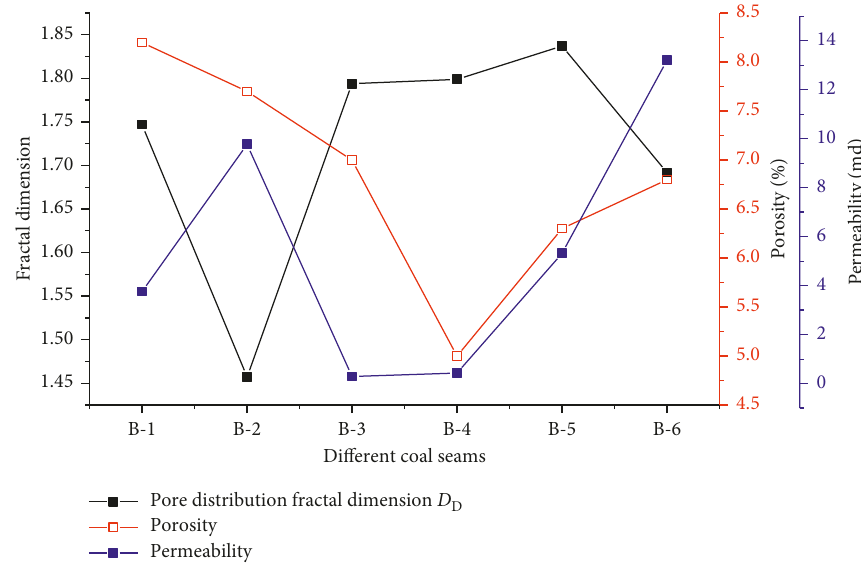
Figure 12: Fractal dimension, porosity, and permeability for the B-1 to B-6 coal samples.